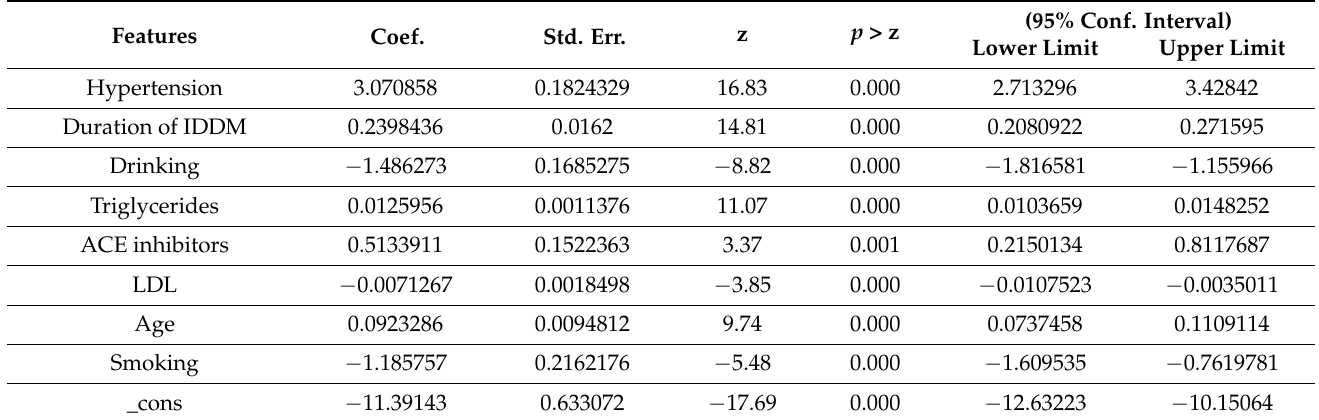
Table 3. Using the XGB feature ranking approach, the multivariate logistic regression analysis for CKD prediction with the top-8 factors.